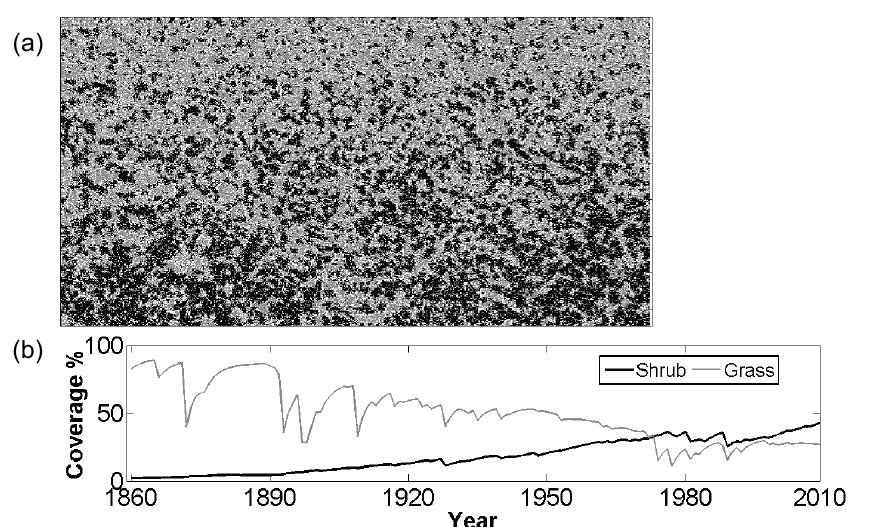
Fig. 4 (a) Final vegetation distribution combining all the factors; (b) time series of percent coverage of PFTs in the modelled catchment over 150